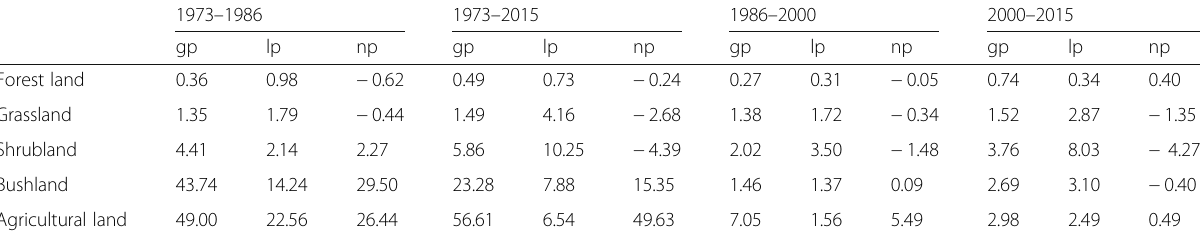
Table 4 Gain-to-persistence (gp), loss-to-persistence (lp), and net change-to-persistence (np) ratios of LULC categories for the 1973